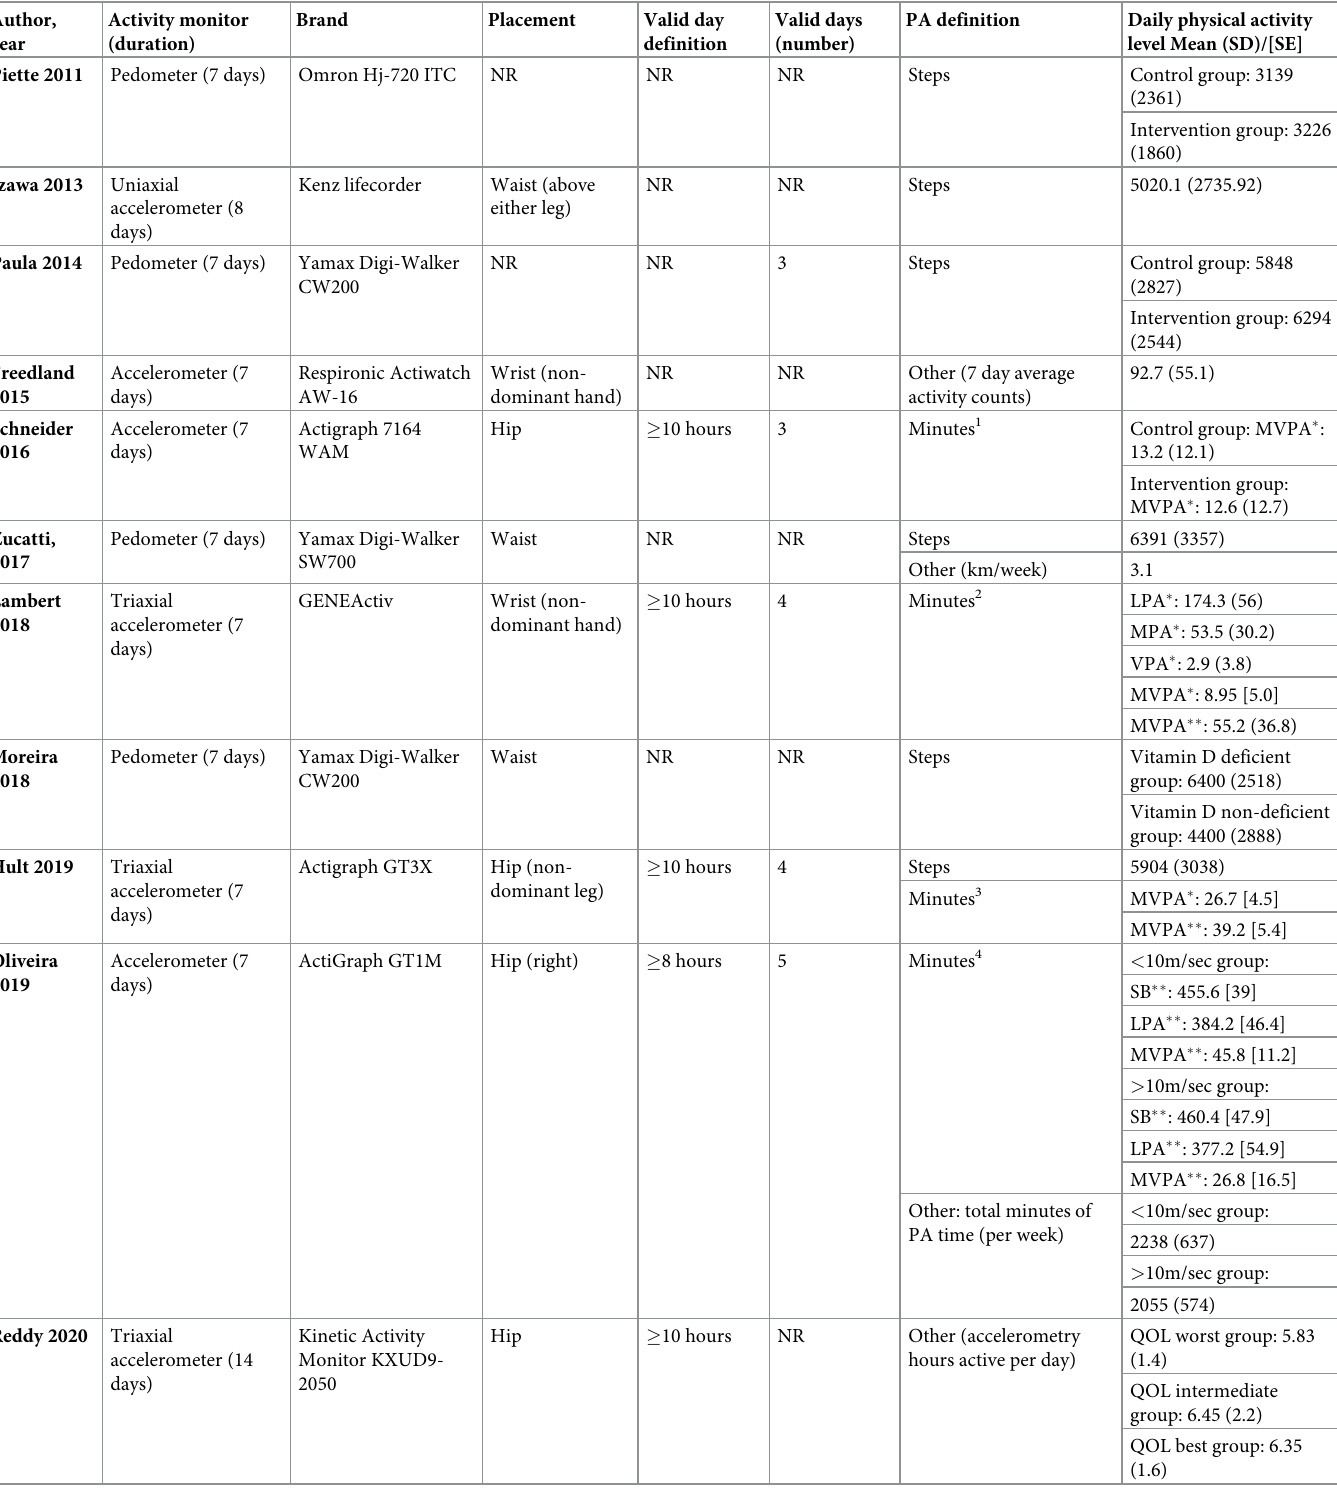
Table 2. Physical activity measurements in the included